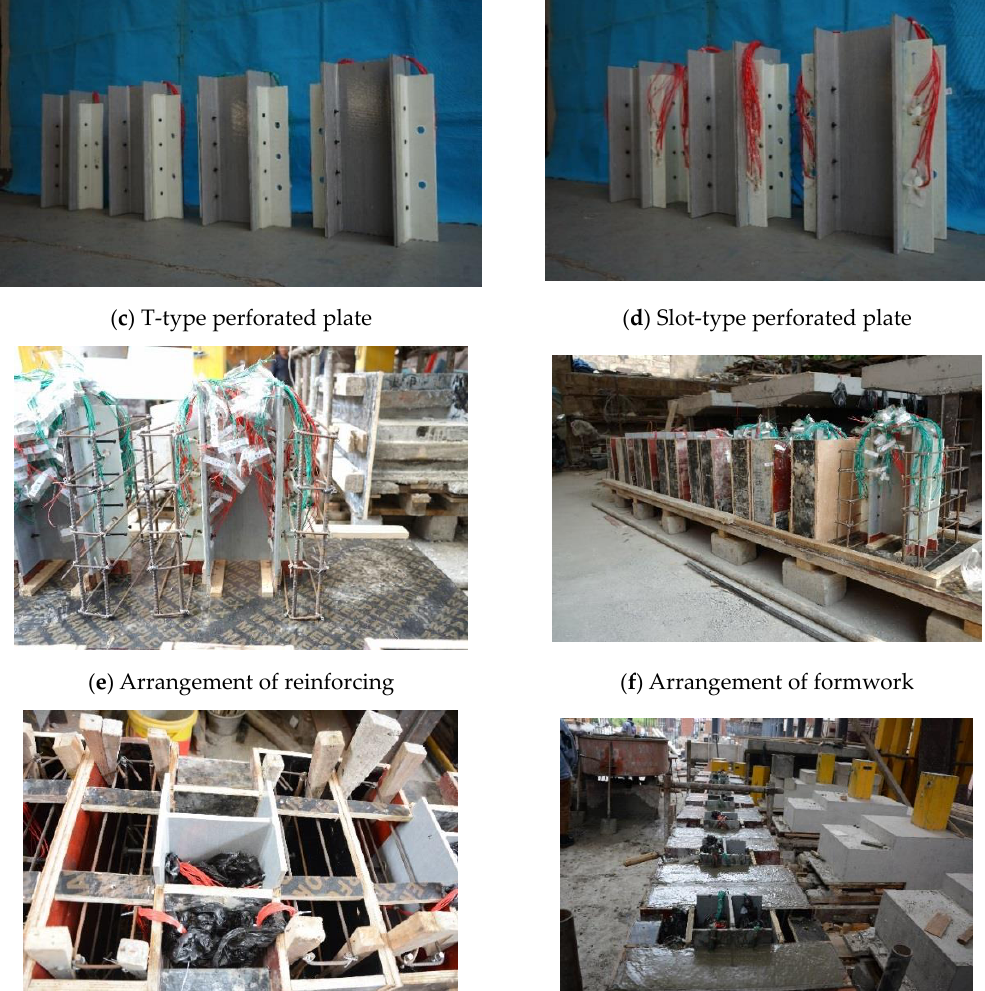
Figure 2. Images of fabricated specimens.